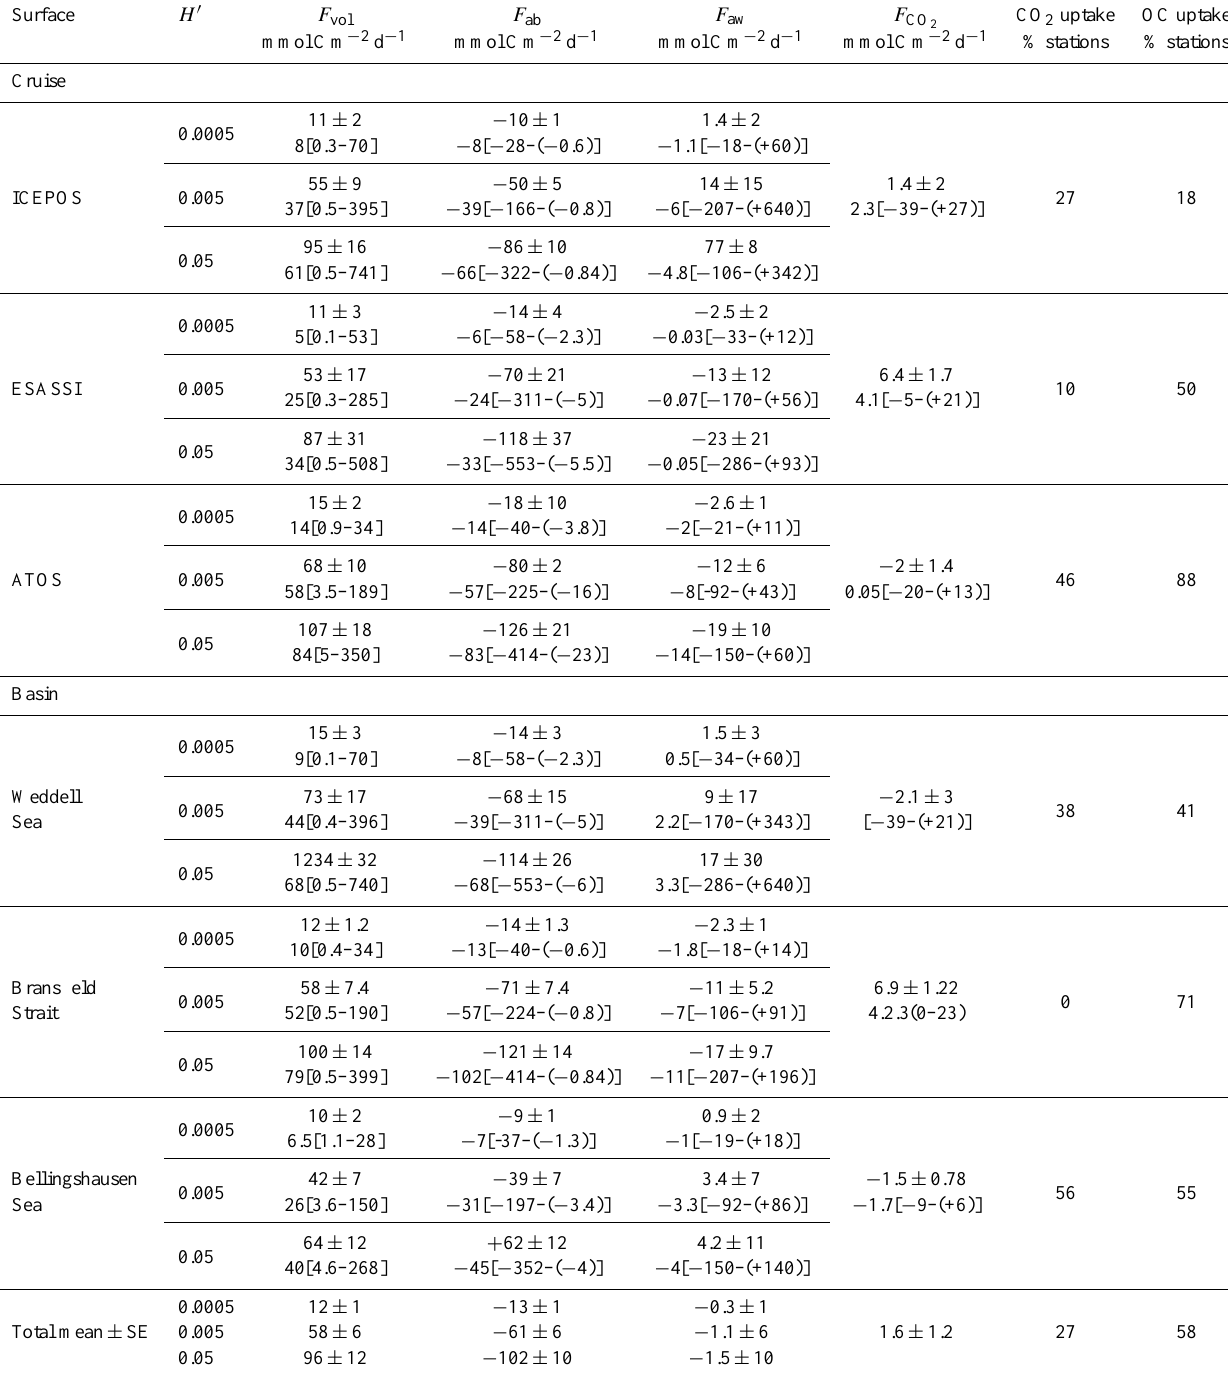
Table 3. Mean ± standard error (SE), median and ranges for fluxes of organic carbon ( F vol , gross volatilization; F ab , gross absorption; F aw , net OC air–seawater exchange) for three different H 0 values (0.0005, 0.005, 0.05), and CO 2 ( F CO ICEPOS in 2005, ESASSI in 2008 and ATOS-Antarctica in 2009. Data were grouped into cruises and areas. The percentage of stations with undersaturated CO 2 and OC uptake by the ocean are also